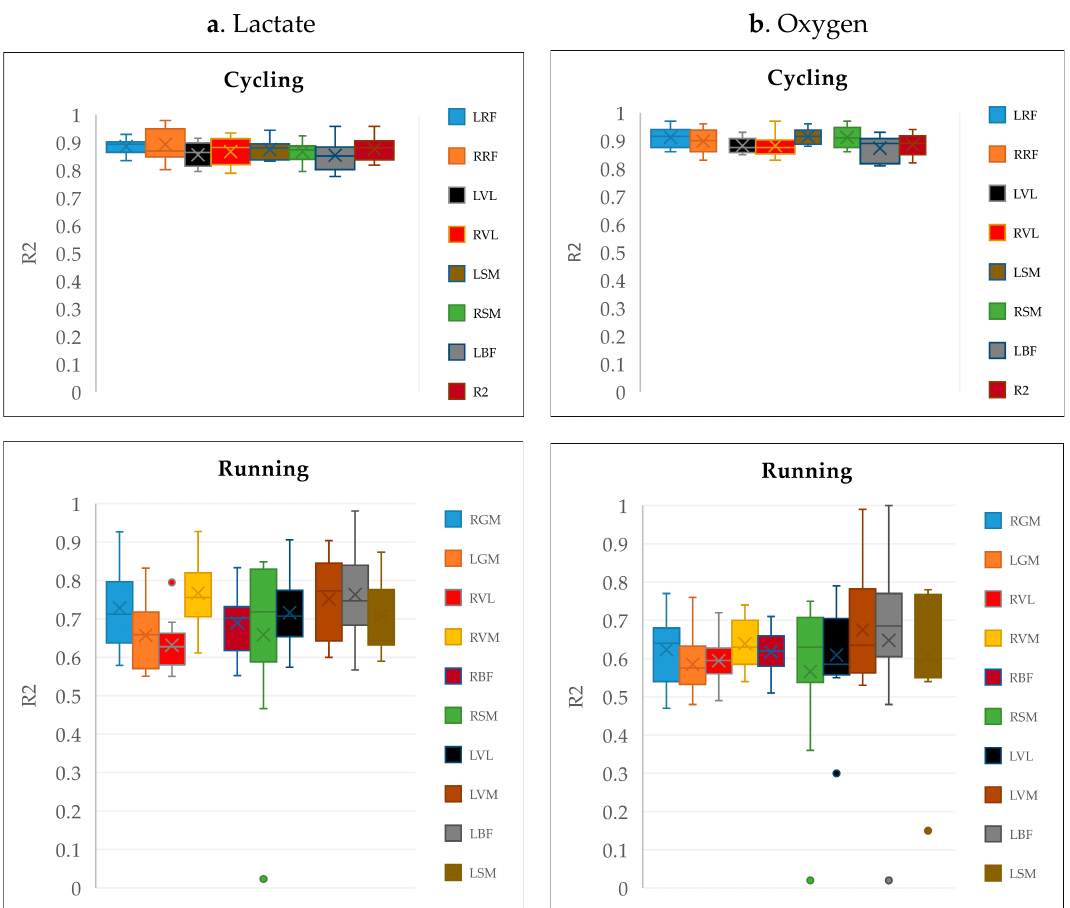
Figure 4. A comparison between R 2 boxplots obtained using random forest (RF) regression and frequency-based features from cycling and running data. ( a ) depicts the boxplots estimated using lactate. ( b ) depicts the boxplots estimated using the oxygen uptake. Dots represent outliers, and crosses represent mean R 2 . * Muscle abbreviations used in the cycling study: *RF: Rectus Femoris, *VL: Vastus Lateralis, *SM: Semitendinosus, *BF: Biceps Femoris. R* and L* represent right and left legs, respectively.